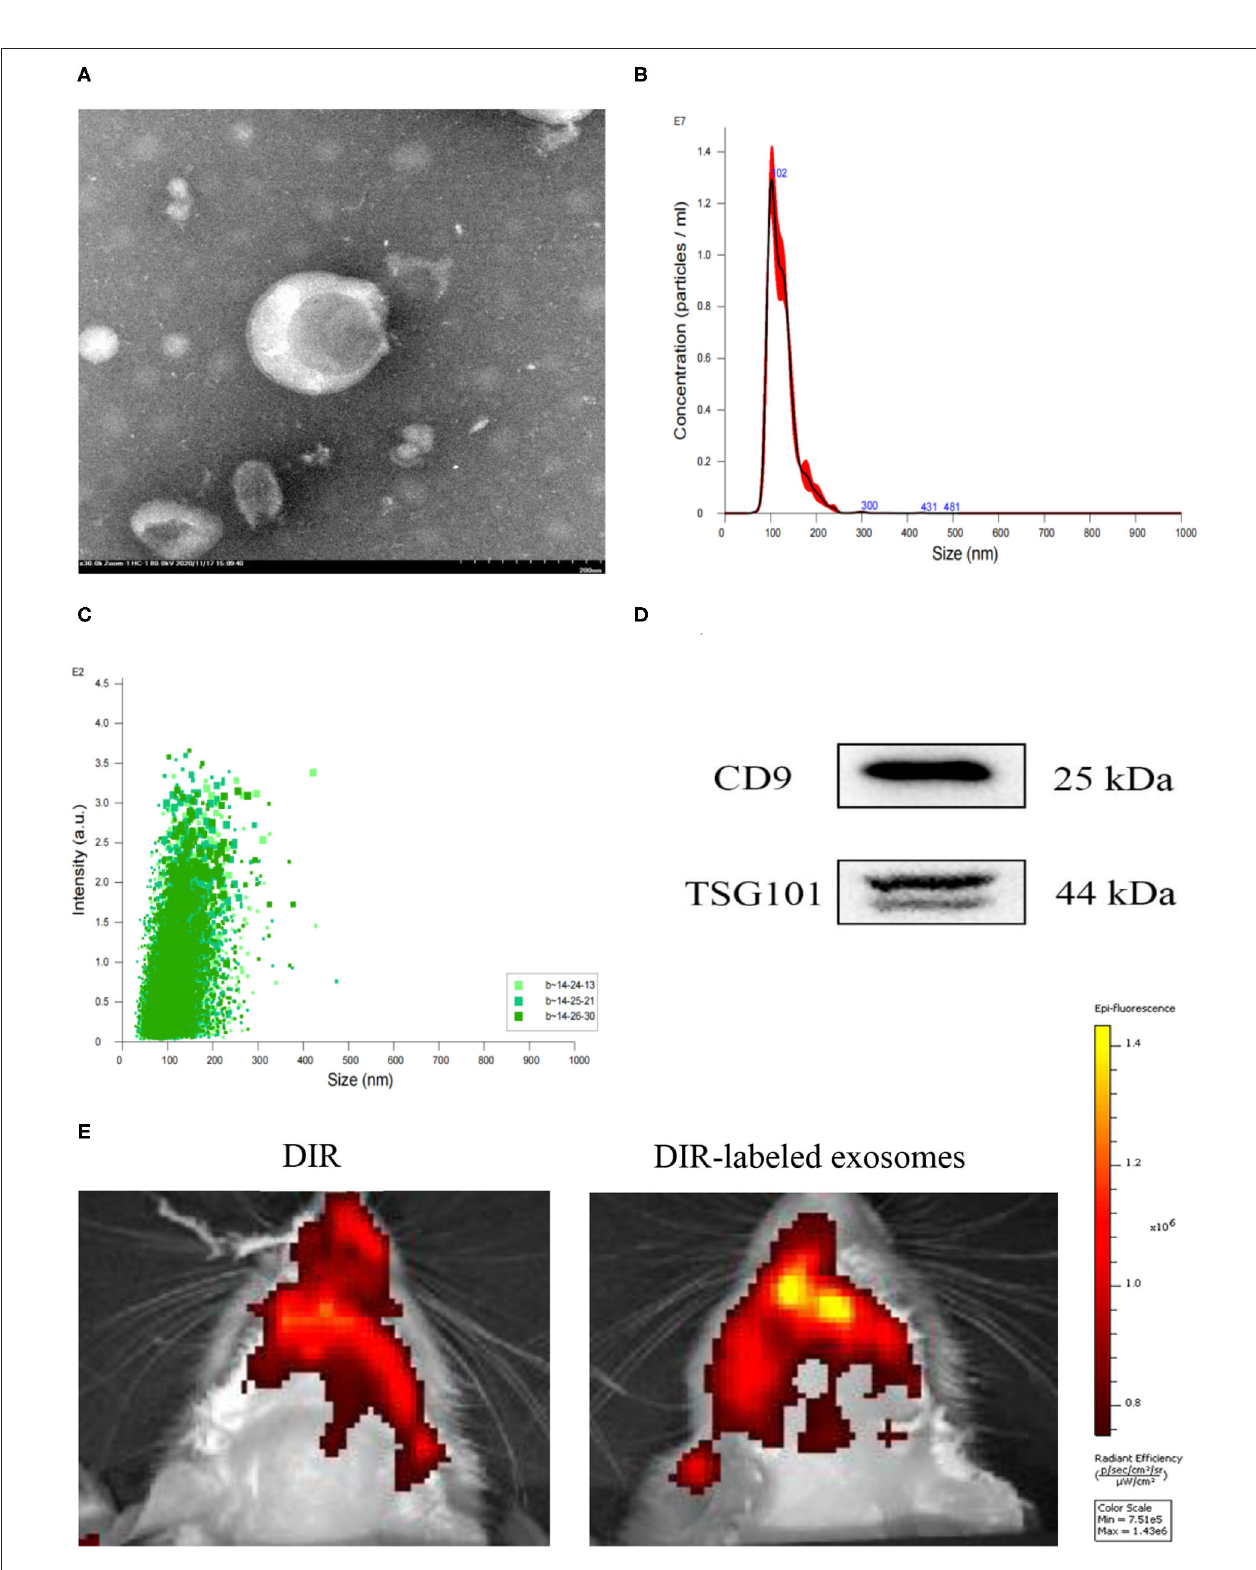
FIGURE 2 | Identification and labeling of exosomes. (A) Morphological observation of exosomes under a transmission electron microscope (TEM, scale bar = 200nm). (B,C) Particle size distribution measured using NTA. (D) The exosome surface marker proteins CD9 and TSG101 were detected using Western blotting. (E) Distribution of DIR-labeled exosomes injected through the tail vein in the brain.